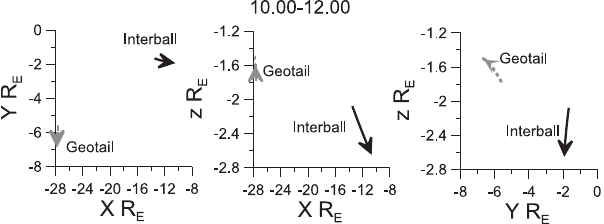
140, where α z = 10 − 2 , α x = 10 − 3 , v D = 0 . 025, and w D